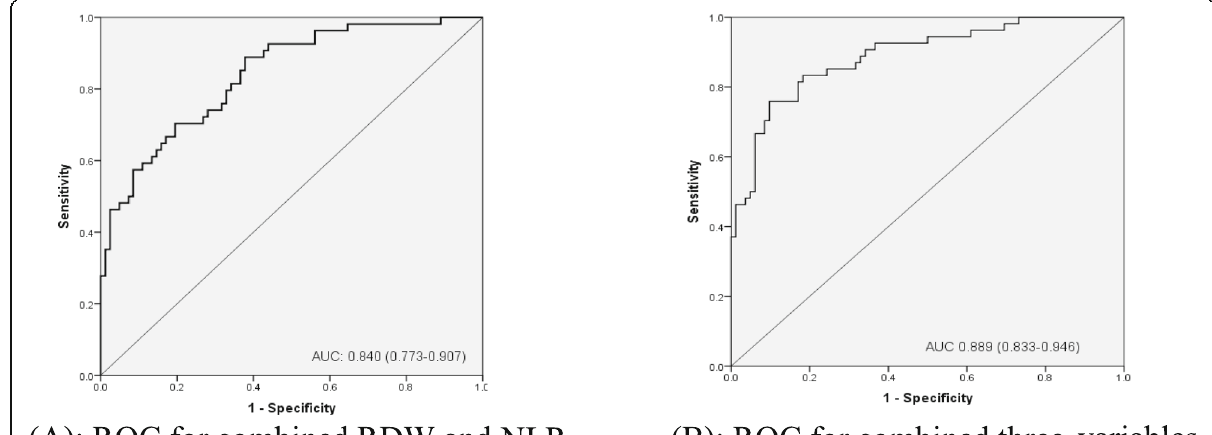
Fig. 4 a ROC for combined RDW and NLR. b ROC for combined three